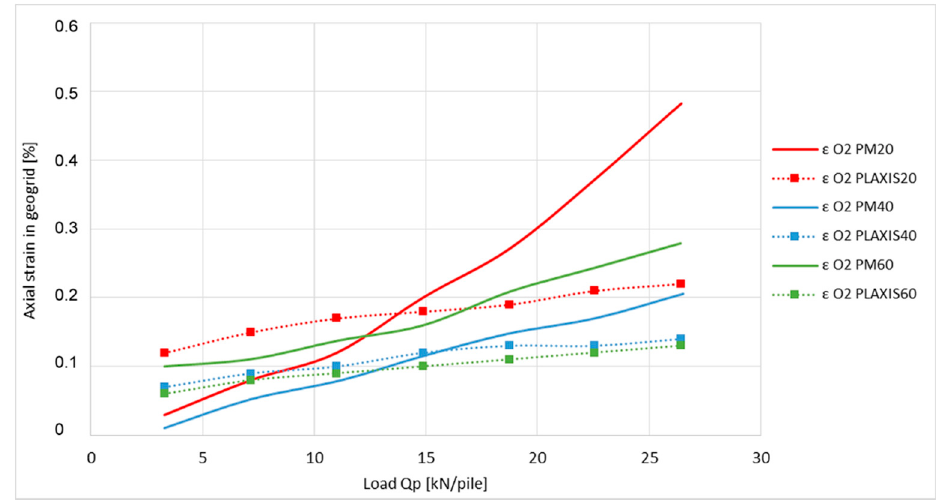
Figure 14. Comparison of axial strain of geogrid at place O2.